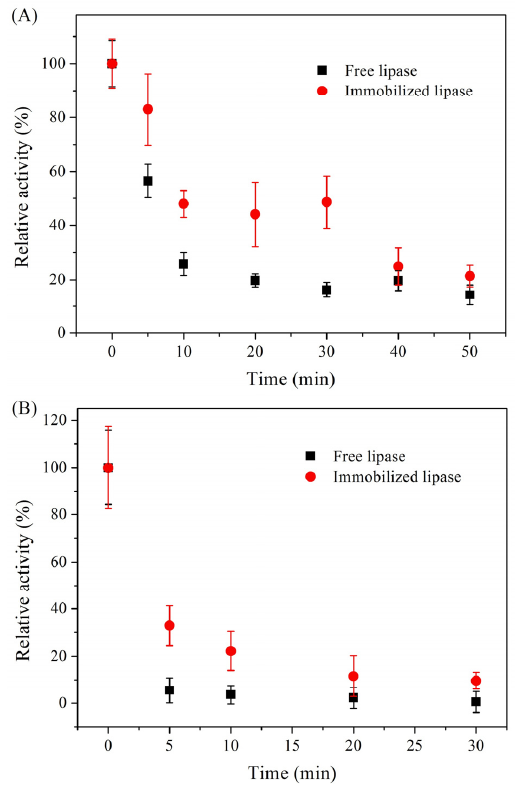
Figure 7. Temperature tolerance of free lipase QLM ( blank ) and immobilized enzyme ( red ) at 50 °C ( A ) and 70 °C ( B ).